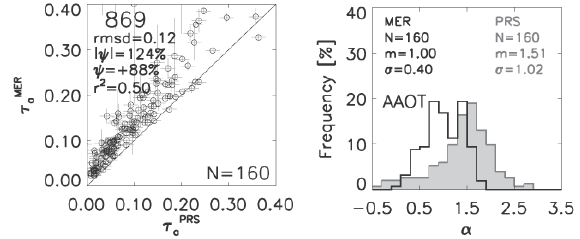
Fig. 12. Same as in Fig. 11, but with data from the 3rd